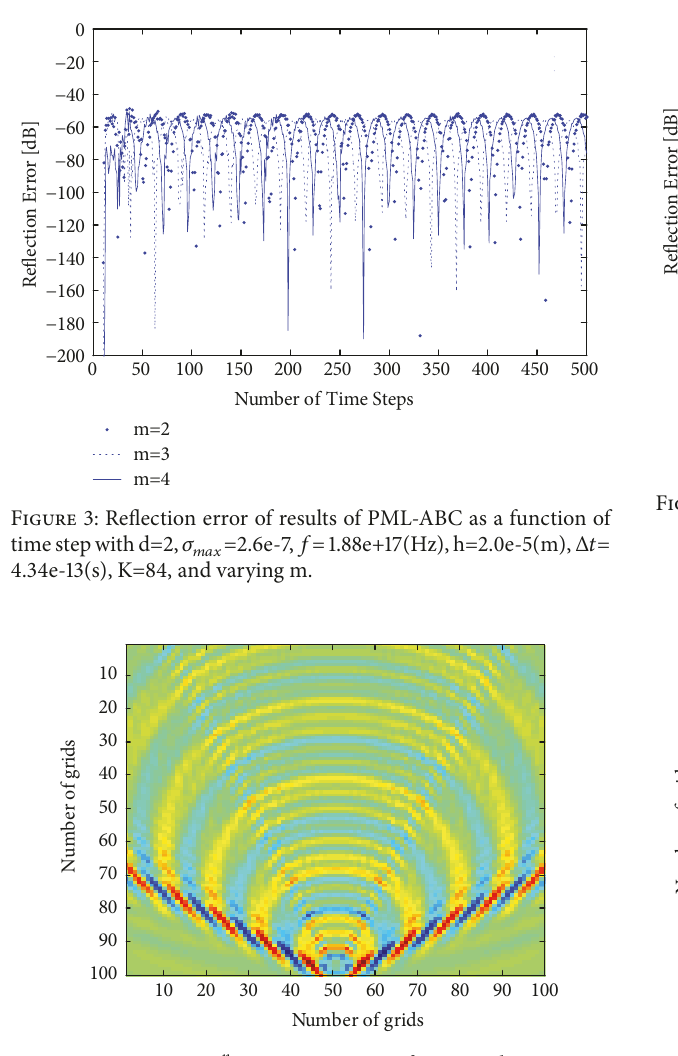
Figure 4: √𝜇𝐻 𝑛 𝑧 at time step n=32 for Example II. 𝑖,𝑗